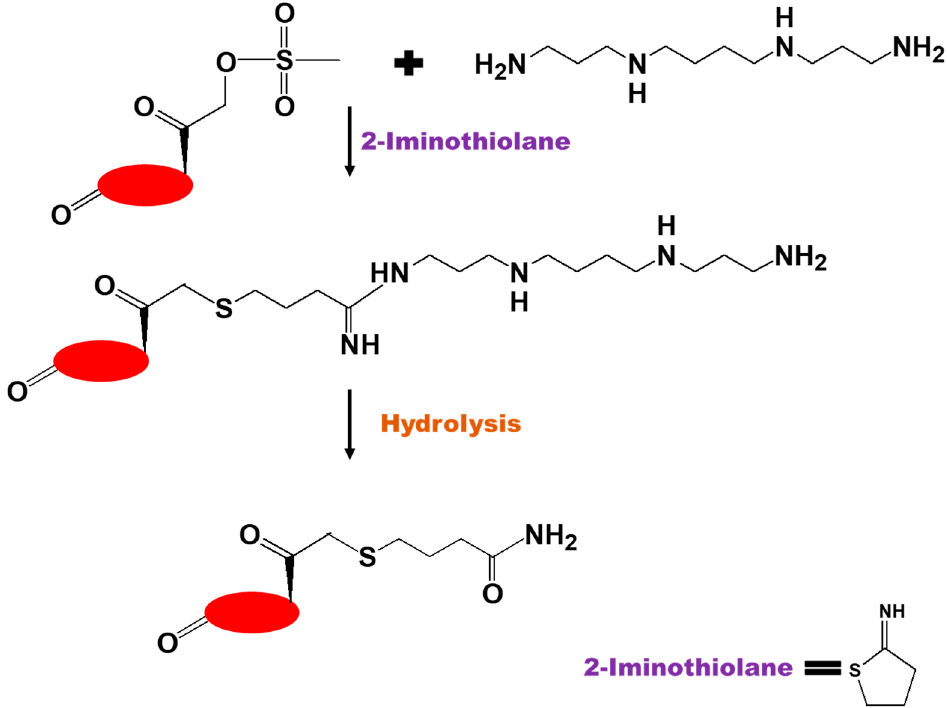
Figure 10. Scheme for the synthesis of dexamethasone -NH 2 by 2-iminothiolane (Traut’s reagent) chemistry [22].